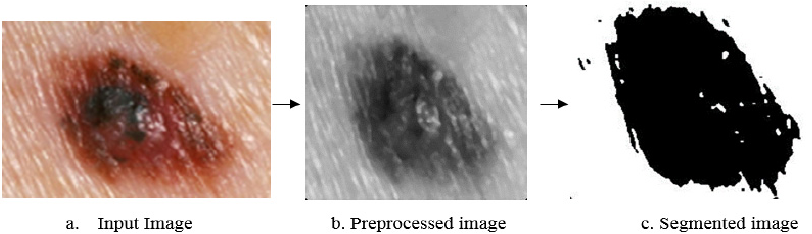
Figure 5. Normalized Otsu’s Segmentation output with the pre-processing step. ( a ) Input Image ( b ) Preprocessed image ( c ) Segmented image. Wavelet coefficients were derived from the segmented images, and the entropy- based and statistical features were extracted from the coefficients. Entropy-based and sta- tistical features comprise the feature vector for classification. The results of the classifica- tion are given in Table 3. Table 3. Performance analysis and comparison chart between the classification